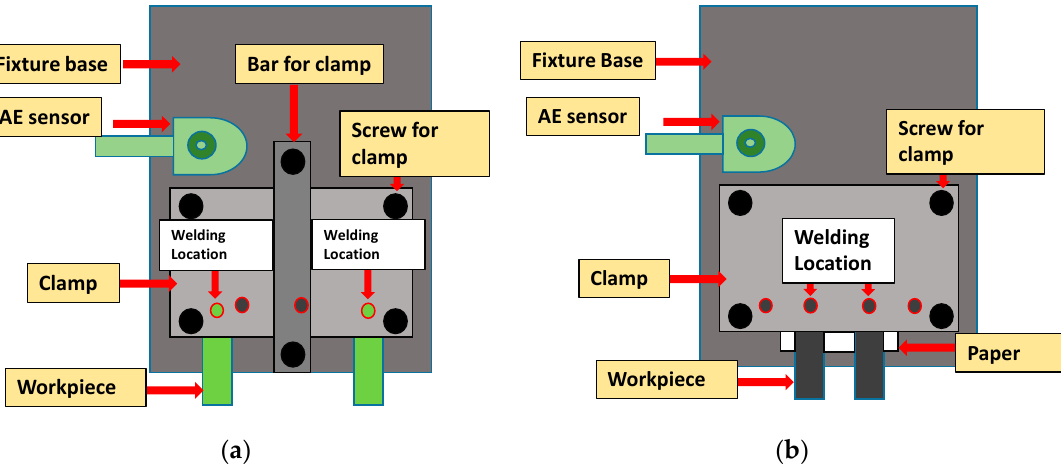
Table 2. Parameter settings for the generation of proper contact and loss of contact [12].